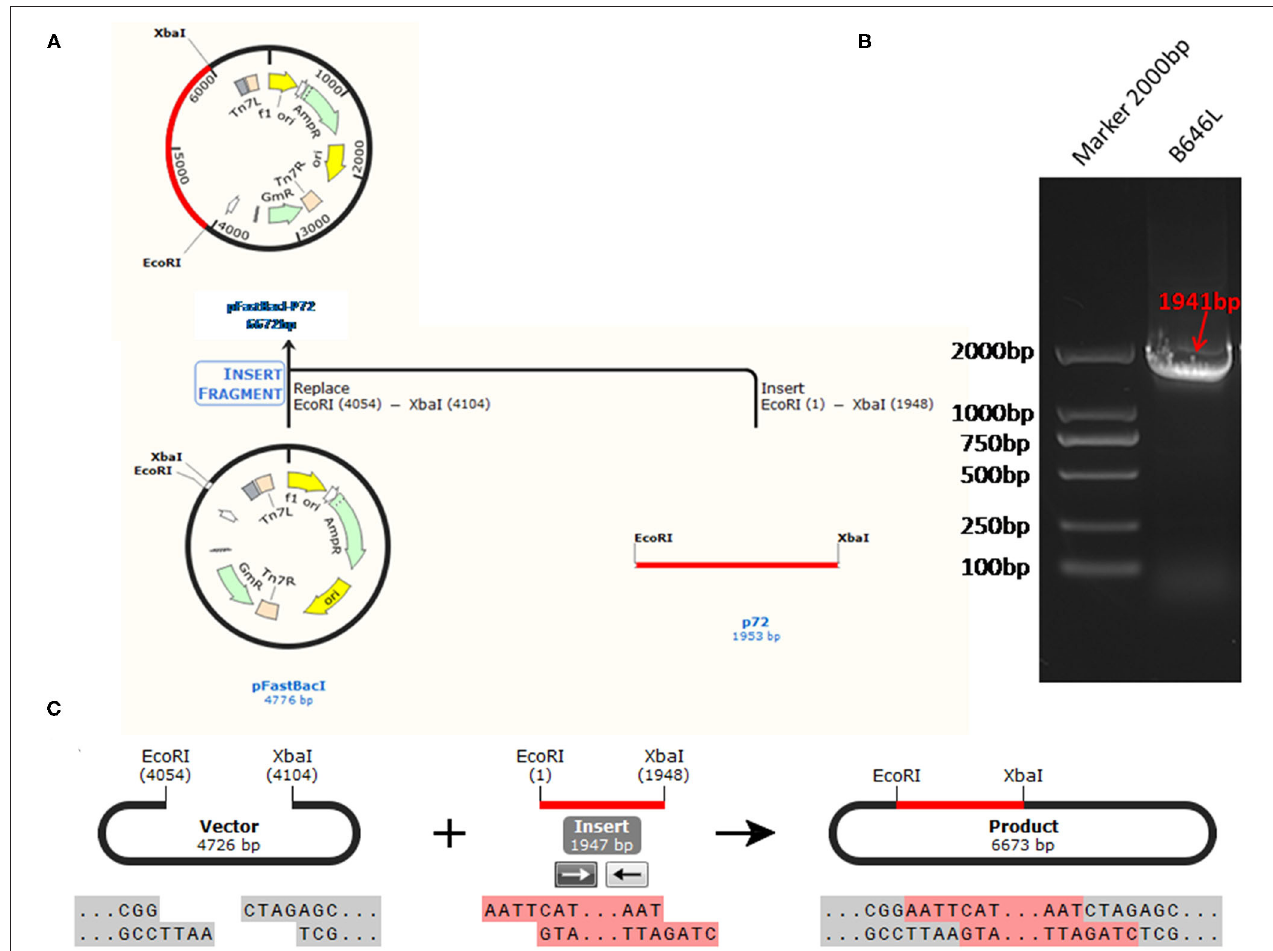
FIGURE 1 | The strategy for the standard plasmid construction. (A) The recombination process of objective gene ASFV VP72 (B646L) and vector pFastBacI. (B) The size of target gene, ASFV B646L, was 1,941bp on 1% agarose gel electrophoresis. (C) The cleavage sites of the recombination process is EcoR I/Xba